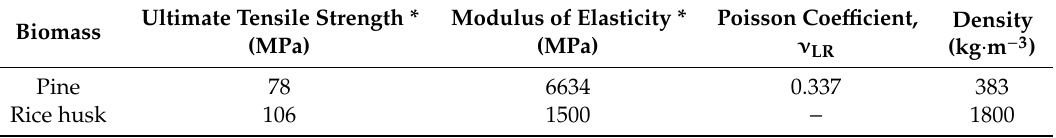
Table 1. Typical mechanical properties for pine and rice husk. Adapted from [17,18]. Ultimate Tensile Strength * Modulus of Elasticity * Poisson Coe ffi cient, Density Biomass ν LR (MPa) (MPa) (kg · m − 3 ) Pine 78 6634 0.337 383 Rice husk 106 1500 − 1800 * longitudinal